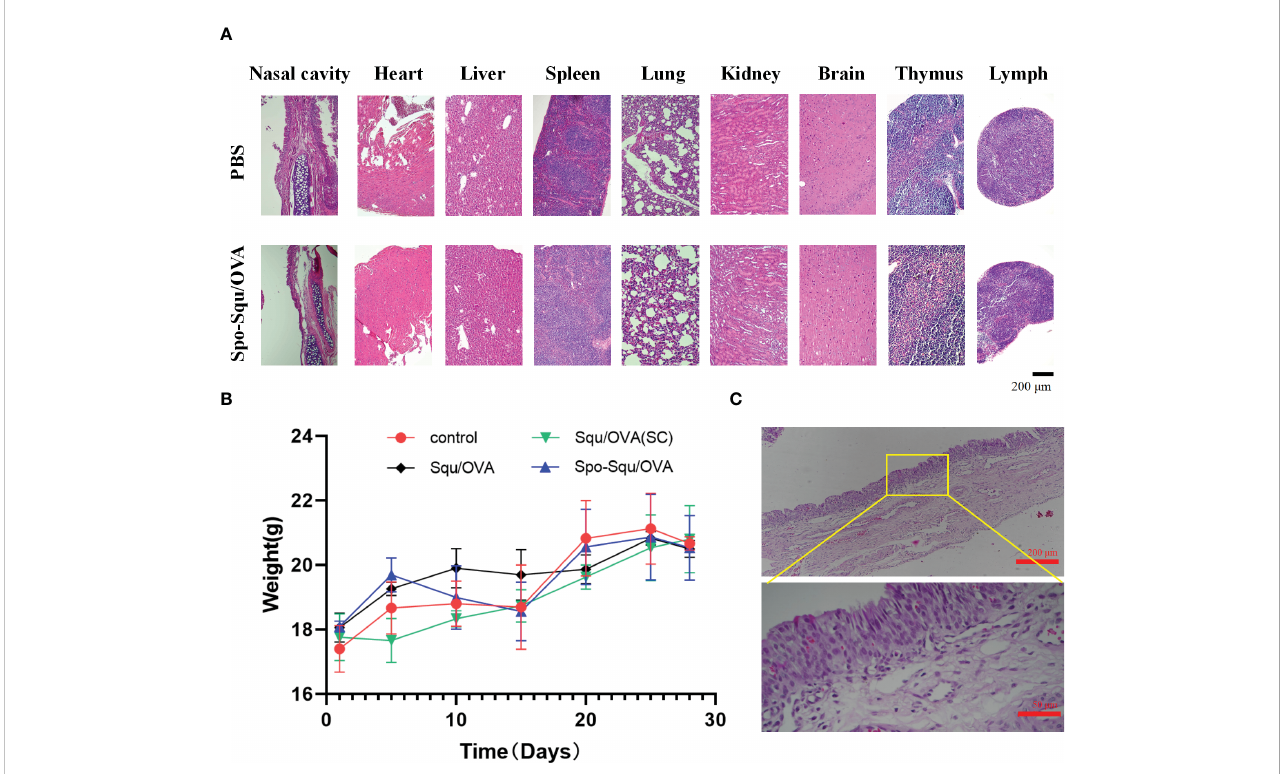
FIGURE 5 Biosafety of Spo-Squ/OVA in v ivo. (A) H&E staining and hi stopathological exam i nati on of different organs on day 28 after primary immunization. Scale bar: 200 µm (B) Body weight of mice during vaccination. (C) H&E staining and histopathological examination of nasal mucosa in rabbits after 7 days of continuous administration of Spo-Squ/OVA. Scale bar: 200 µm, 50